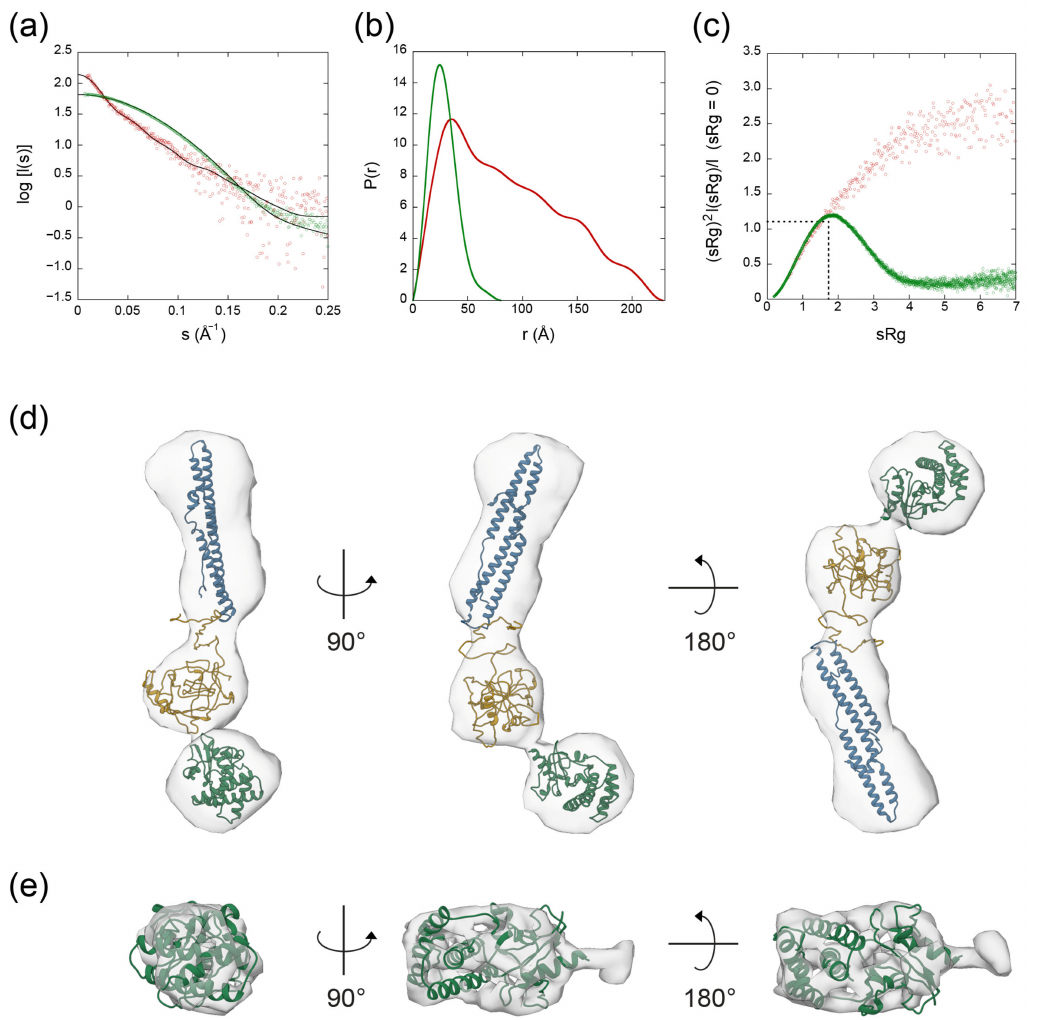
Figure 5. SAXS data for the EspK full-length protein (red) and its C-terminal domain (green). ( a ) Fit of the calculated SAXS scattering curves compared to the experimental scattering signal. ( b ) Pair distribution function plot. ( c ) Dimensionless Kratky plot. The intersection of the dotted black trace corresponds to the value for the reference protein bovine serum albumin (BSA). ( d ) Ab initio molecular envelope of the full-length EspK showing the fit of the models corresponding to the N-terminal (residues 1–180 in blue), the flexible linker (residues 181–438 in yellow), and C-terminal region (residues 484–729 in green). ( e ) Ab initio molecular envelope of the C-terminal region of EspK showing the fit of the corresponding